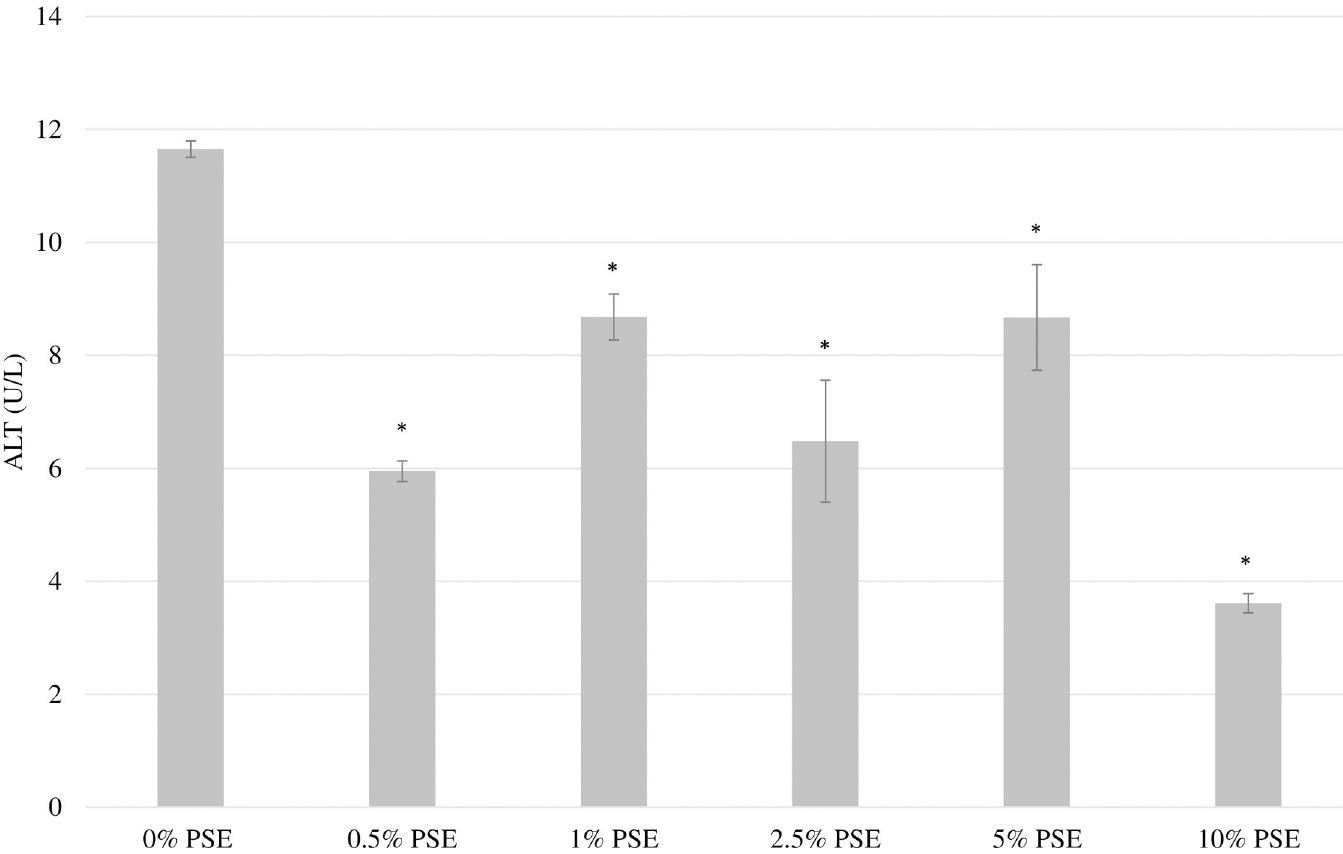
Fig 2. Effect of varying concentrations of peanut skin extract on ALT leakage from HepG2 cells. HepG2 cells were exposed to varying concentration of peanut skin extract for 24 hours and the level of transaminase enzyme were measured. Each treatment was done in triplicate and data are expressed as mean ± SEM. � Indicates statistically significant difference at P <